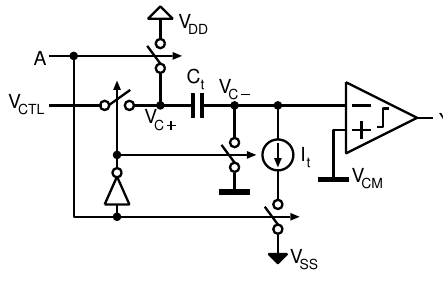
Figure 10. Schematic of the